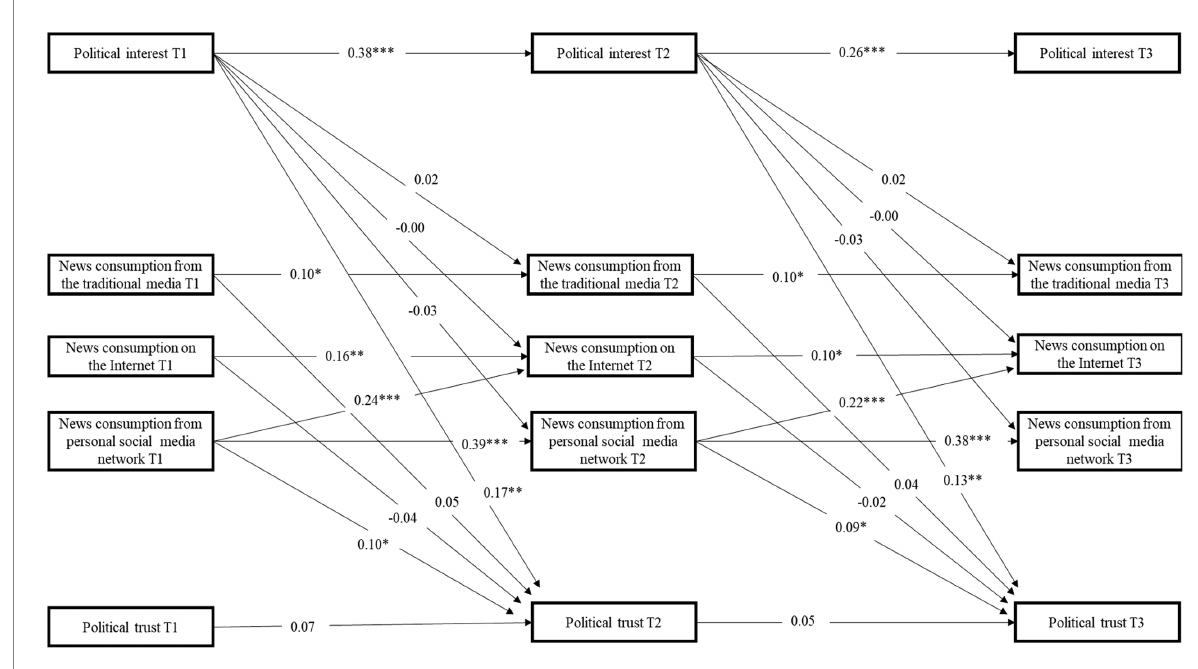
FIGURE 1 Results of the model assessing the intention to consume news via personal social media network on political trust ( N = 216). * p < 0.05, ** p < 0.01, *** p < 0.001. T1 = Time 1; T2 = Time 2; T3 = Time